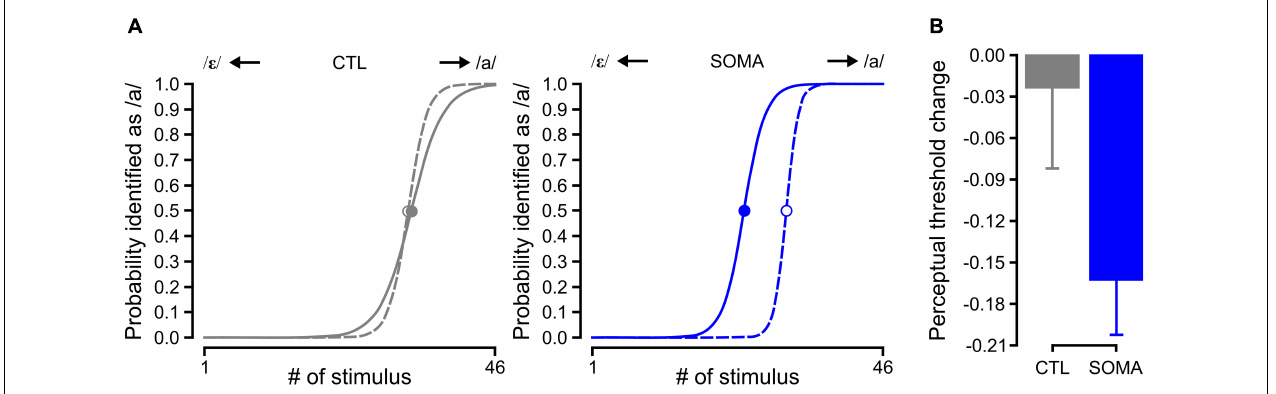
FIGURE 2 | (A) The estimated psychometric function in Baseline (dashed) and Aftereffect (solid) phases for control and somatosensory conditions in representative participants. Filled (Aftereffect) and open (Baseline) circles represent the 50% crossover value of the psychometric function. The left panel in gray shows the participant response in the control condition (CTL); the right panel in blue shows the response in the condition that received somatosensory stimulation (SOMA). (B) Averaged perceptual change of the 50% crossover values for the control (left, gray) and somatosensory condition (right, blue), respectively. Error bars represent standard errors across participants.